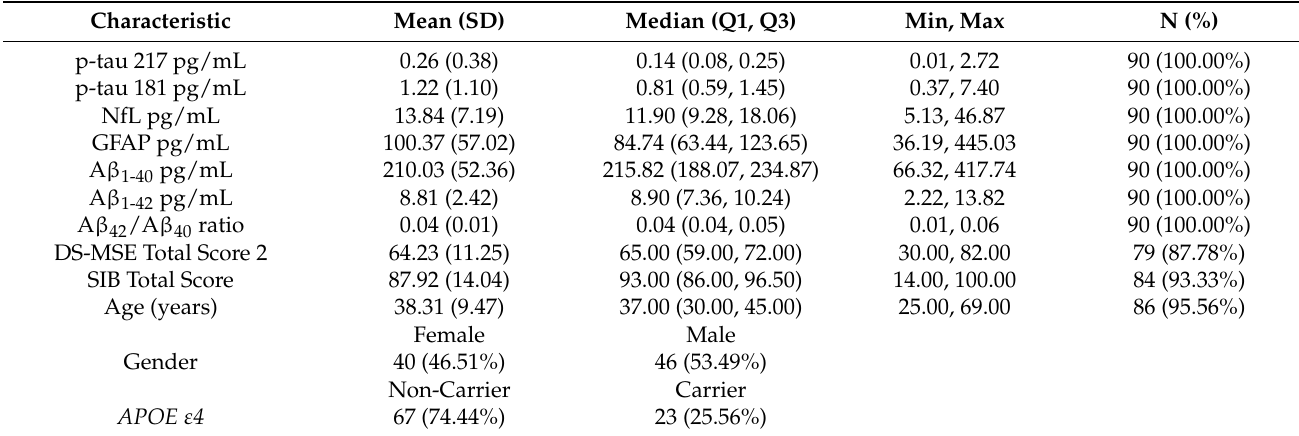
Table 1. Demographics and baseline biomarkers for first 90 subjects in Longitudinal Investigation for Enhancing Down Syndrome Research (LIFE-DSR) Study.